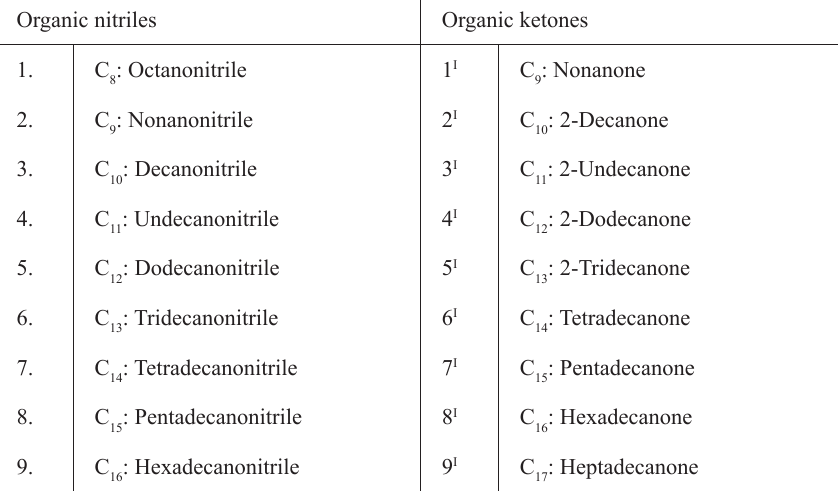
Table 9. Organic nitriles and ketones in the polar component of the neutral sub-